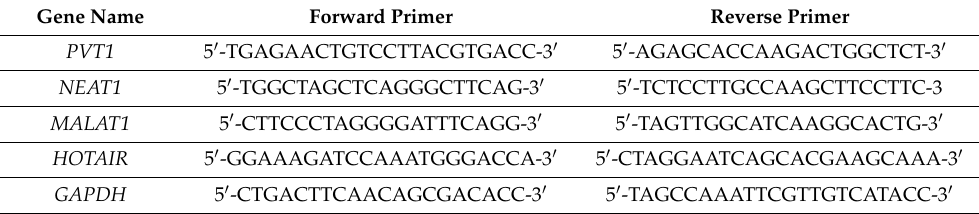
Table 1. The primer sequences used for